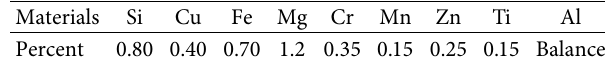
Table 1: Aluminium 6061 T6 quantifed chemical composition in %.